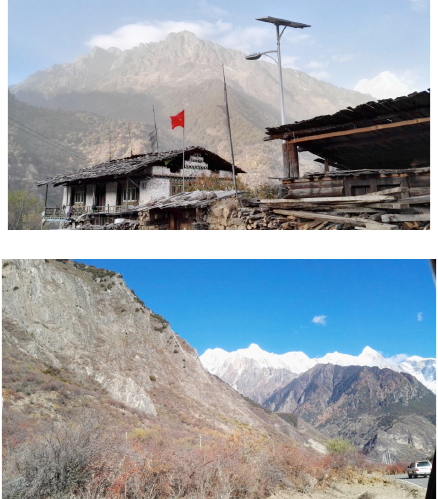
Figure 5. Raising dust after the earthquake (above) no dust